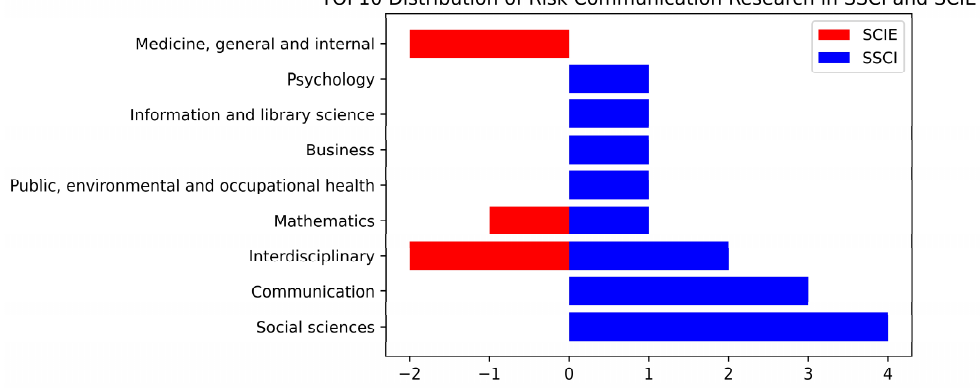
Figure 8. Distribution of top 10 journals crisis and risk communication research in SSCI and SCIE.